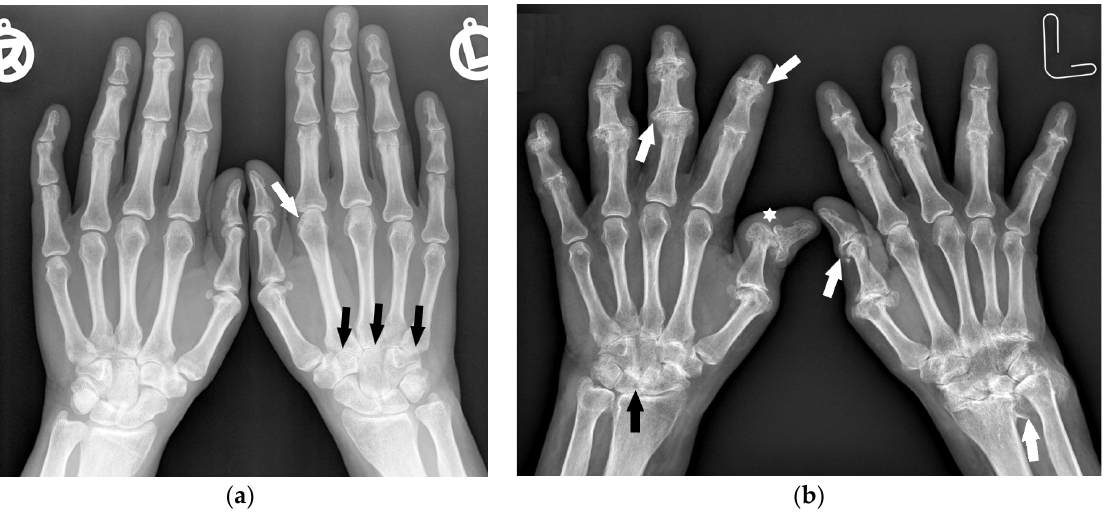
Figure 1. A 40-year-old female with early asymmetric seropositive rheumatoid arthritis (RA). ( a ) Posterior–anterior (PA) radiographs of bilateral hands show narrowing of the left radiocarpal joint (RCJ) and carpo-metatacarpal (CMC) joints (black arrows). Note the bone cyst in the left second metacarpal head and narrowing of the second metacarpophalangeal joint (MCP) (white arrow). ( b ) PA radiograph of the bilateral hands of the same patient, 13 years later, showed progression of the disease with increased juxta-articular osteoporosis. Note the erosive bone changes, advanced destructive changes, and joint narrowing in the RCJ and CMC joints. There are less advanced changes on the right side with joint space narrowing and bone cysts in the wrist (black arrow). Note proliferative osteoarthritic changes in left distal radioulnar joint (DRUJ) and bilateral first MCP and interphalangeal joints (white arrows). There is subluxation of the right thumb interphalangeal (IP) joint (star).